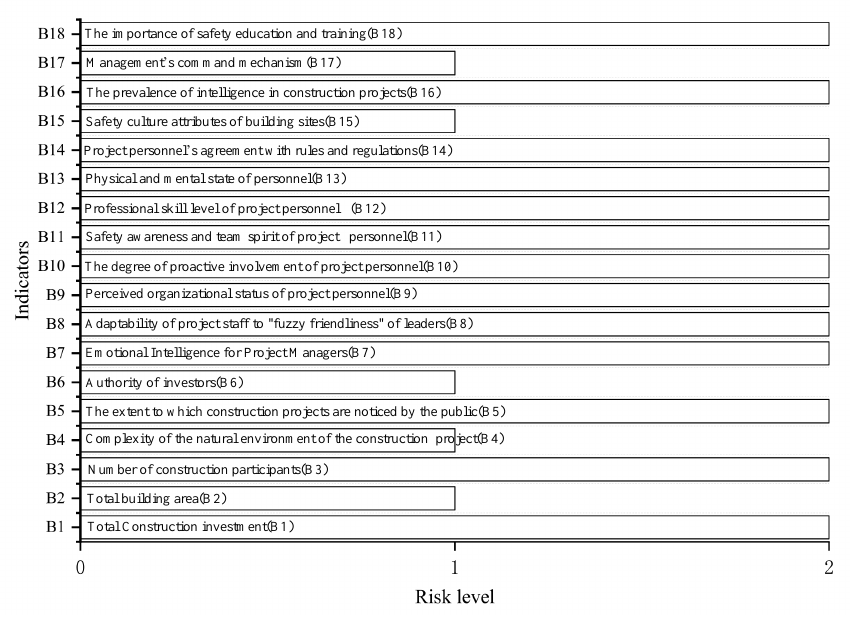
Figure 6. Risk level of each